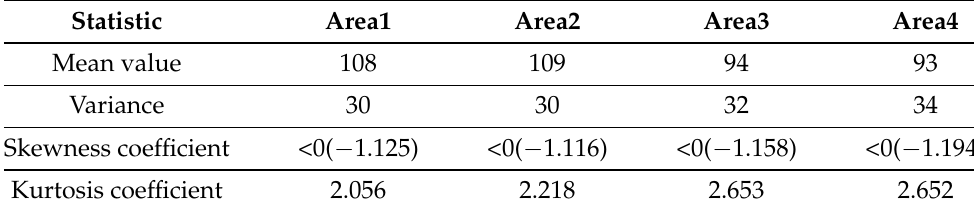
Table 1. The statistical properties.